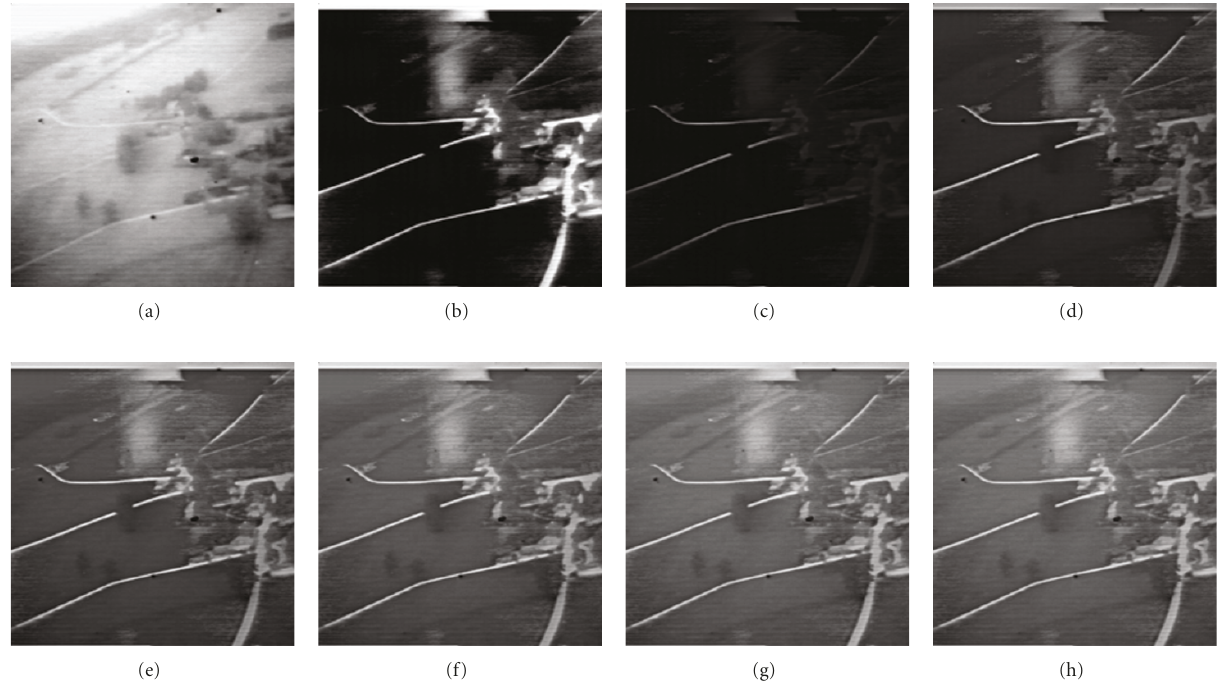
Figure 4: (a) and (b) Original “navigation” source images, image fusion results using the LP/AM fusion rule, and PLIP model operators with (c) γ = 256 (LIP model case), Q W = 0 . 3467, (d) γ = 300, Q W = 0 . 7802, (e) γ = 430, Q W = 0 . 8200, (f) γ = 700, Q W = 0 . 8128 (g) γ = 10 8 , Q W = 0 . 7947, and (h) standard mathematical operators, Q W = 0 . 7947.